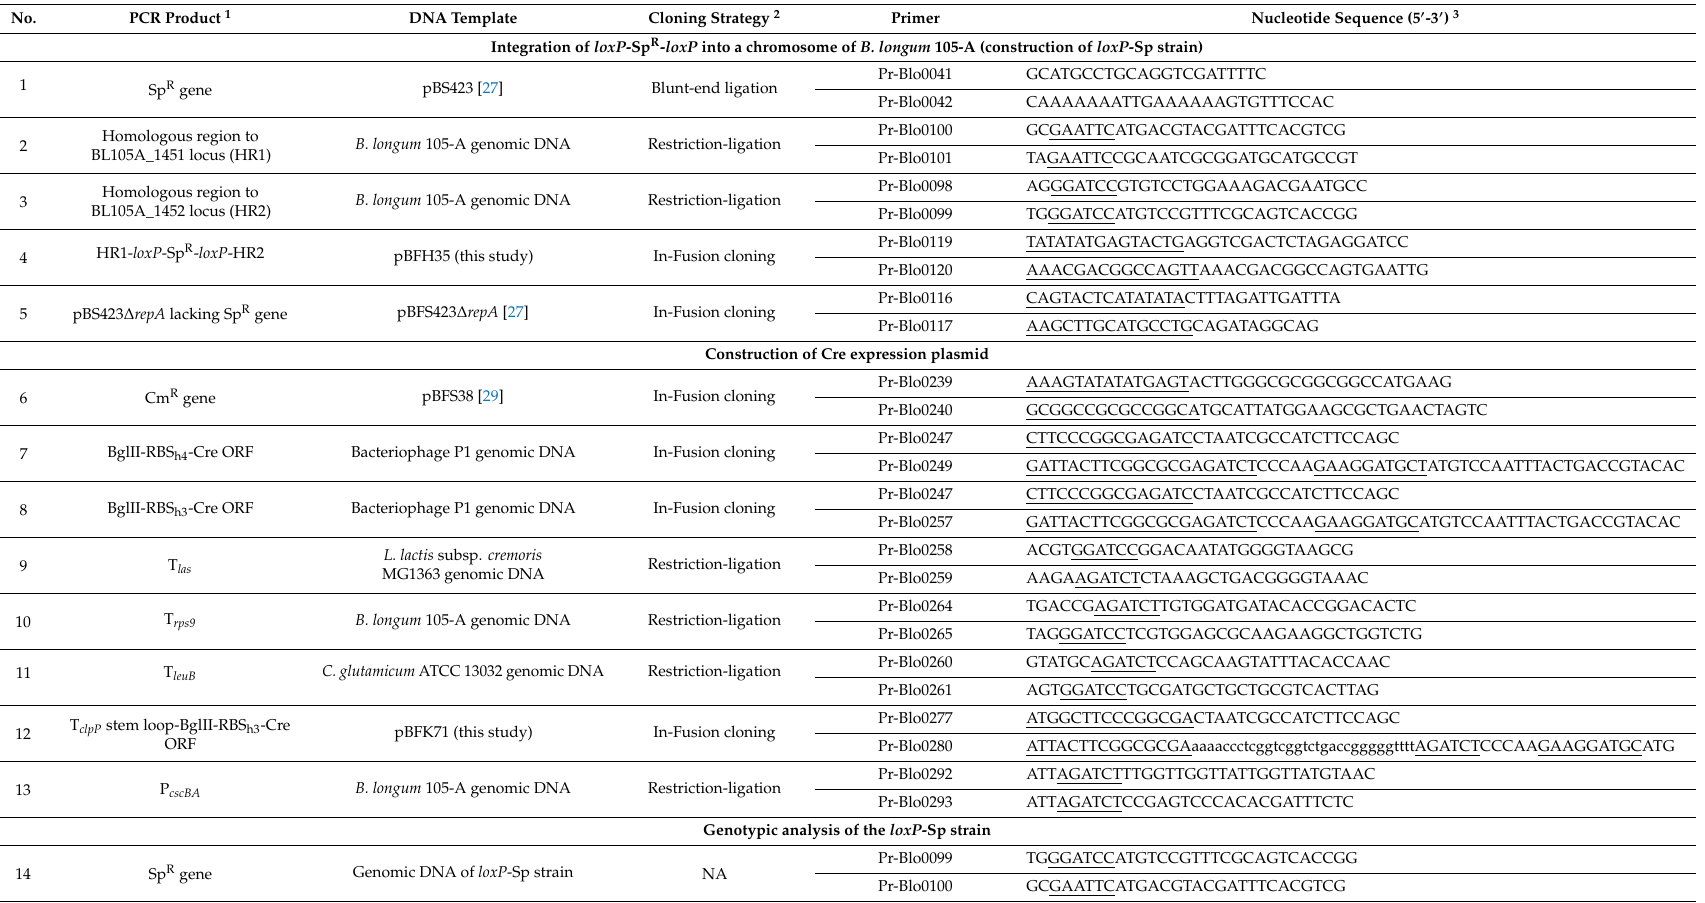
Table 2. Primers and DNA templates used in this